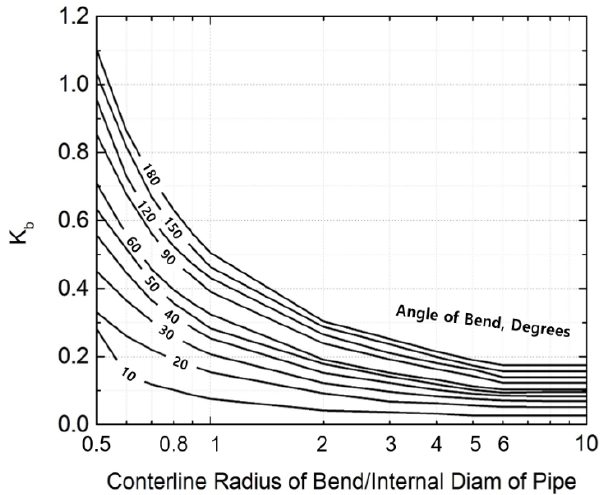
Figure 4. Minor loss coefficient for a bended round pipe (Babcock & Wilcox Co., Barberton, OH, USA, 1978) [19].